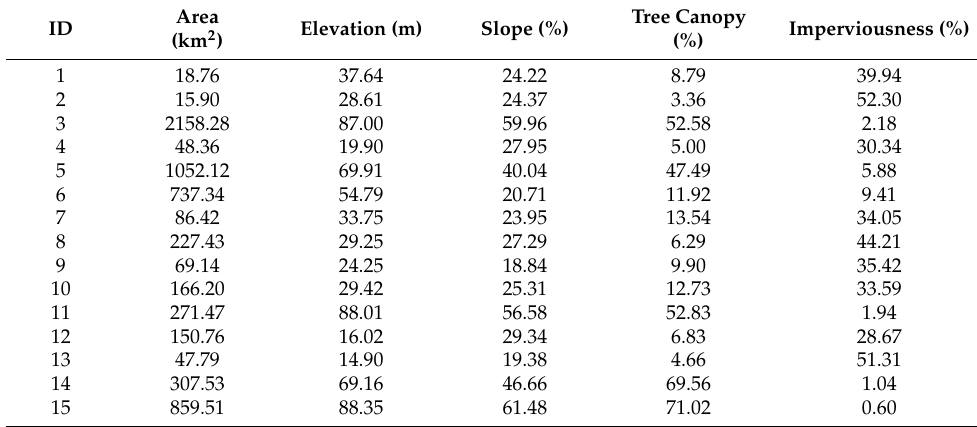
Table 2. Summary of the variables for the 15 watersheds.